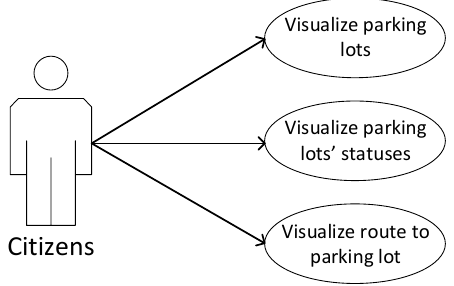
Figure 4. Smart parking application use case diagram—Citizens’ perspective.